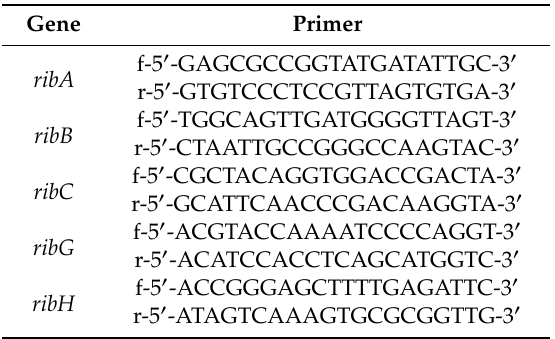
Table 1. Primer sequences used for PCR